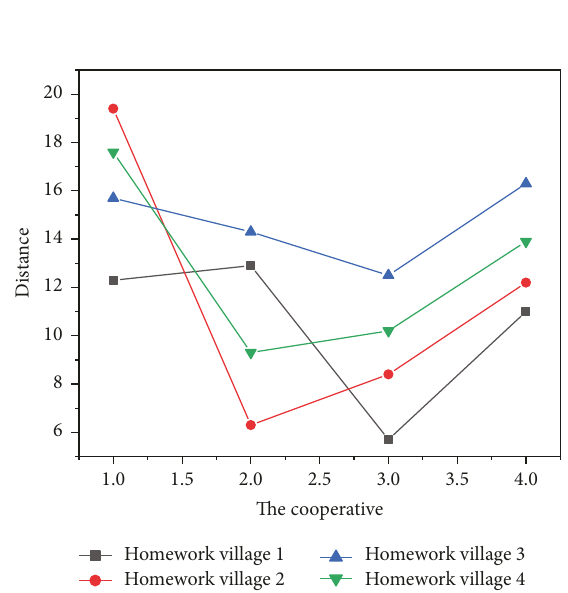
Figure 2: Distance table of cooperatives and operating points.